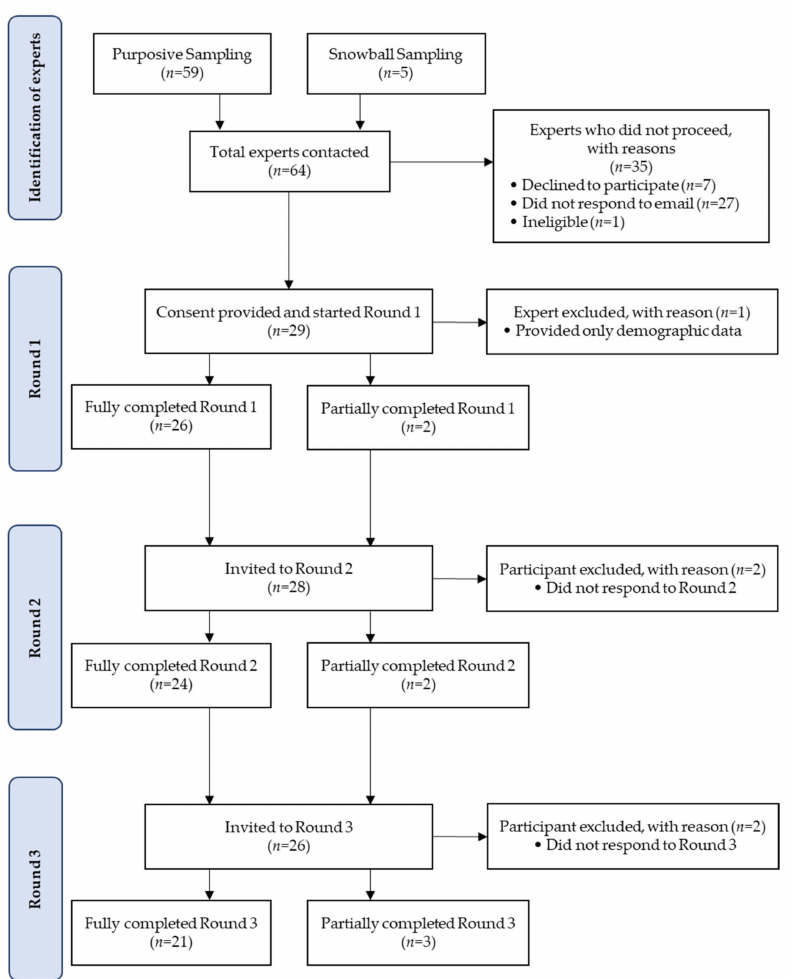
Figure 2. Flow chart of the number of experts from recruitment through to Round 3 of the Delphi